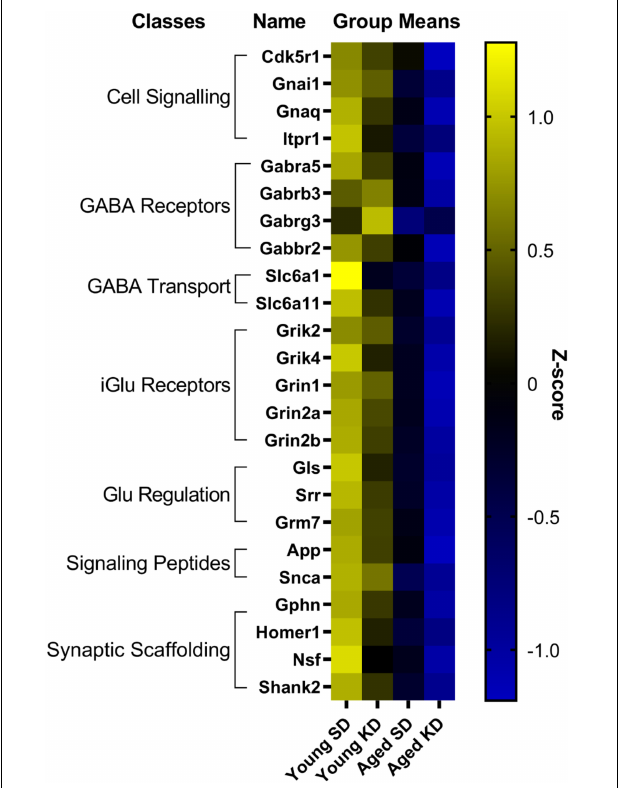
FIGURE 5 | Genes affected by age in CA3. The heat map represents mean z -scores of all genes that were significantly reduced (FDR q = 0.005 threshold) as a function of age. Genes were categorized into biologically relevant processes, and experimental groups were ordered to reflect the main effect of age. Yellow represents greater gene expression, whereas blue represents lower gene expression. Black represents no